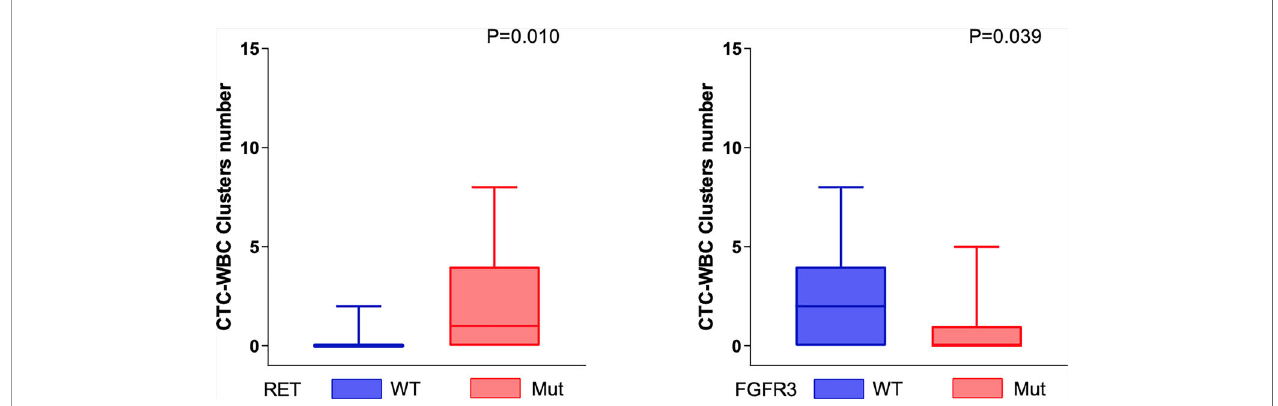
FIGURE 4 | Genomic alterations associated with mesenchymal CTC-WBC clusters. The number of CTC-WBC clusters was positively correlated with the somatic genomic alterations in RET genes (P= 0.01, Mann – Whitney U test) and negatively correlated with the somatic genomic alterations in FGFR3 (P= 0.039, Mann – Whitney U